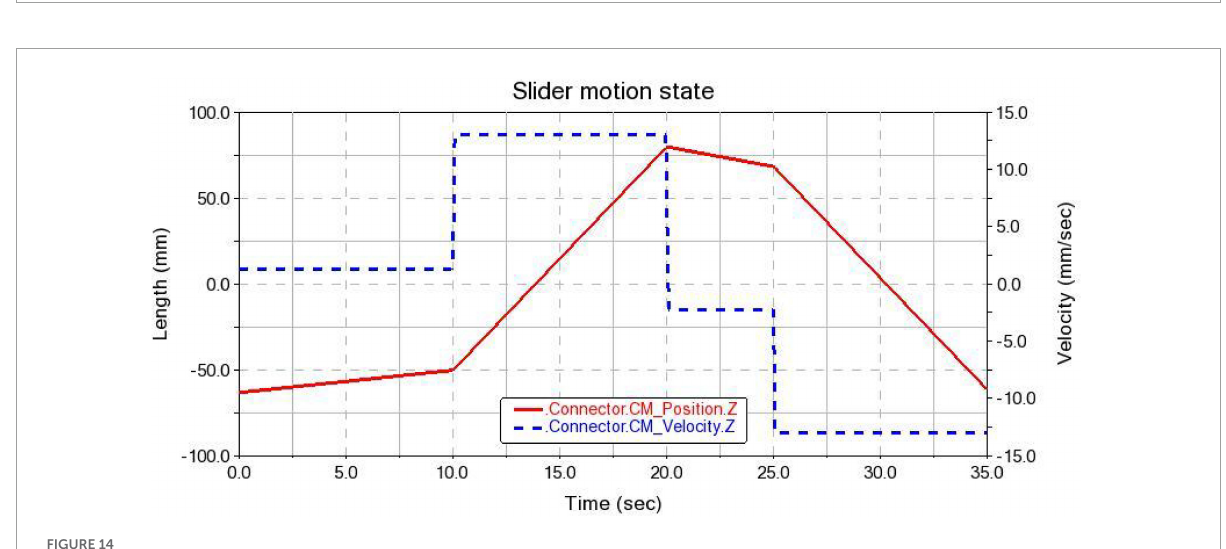
FIGURE14 Slider motion